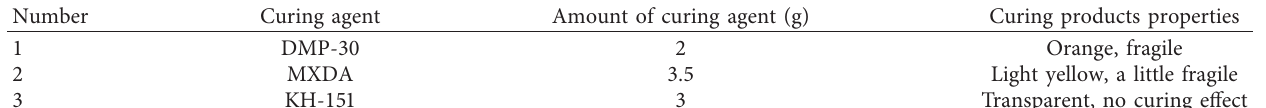
Table 5: The properties of the cured products under various curing agents.